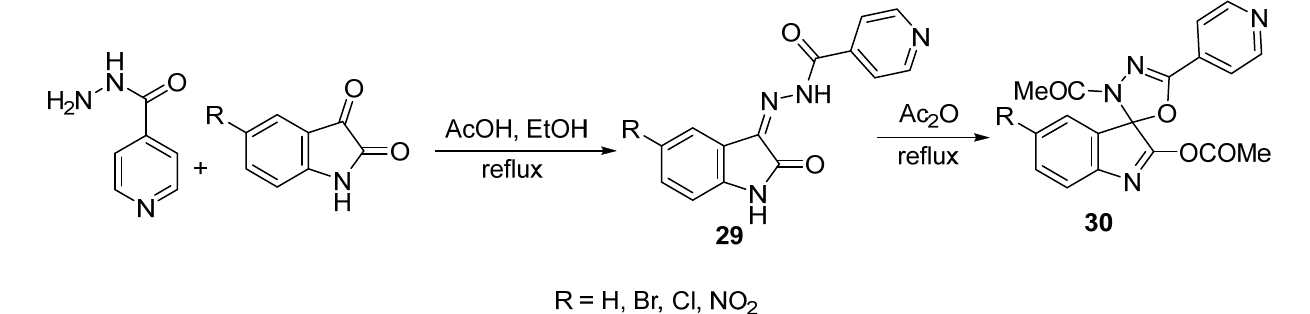
Molecules 2023 , 28 , 618 6 of 34 Scheme 2. Synthesis of spiro[indoline-3,4’-pyrans] 27 and 28 . The spiro[indoline-3,2 ′ -[1,3,4]oxadiazols] incorporated pyridinyl heterocycle 30 was obtained through cyclization of the appropriate hydrazones 29 in refluxing acetic anhy- dride (Scheme 3). Considerable antibacterial ( B. Subtilis , S. aureus , E. coli , S. typhi ) proper-